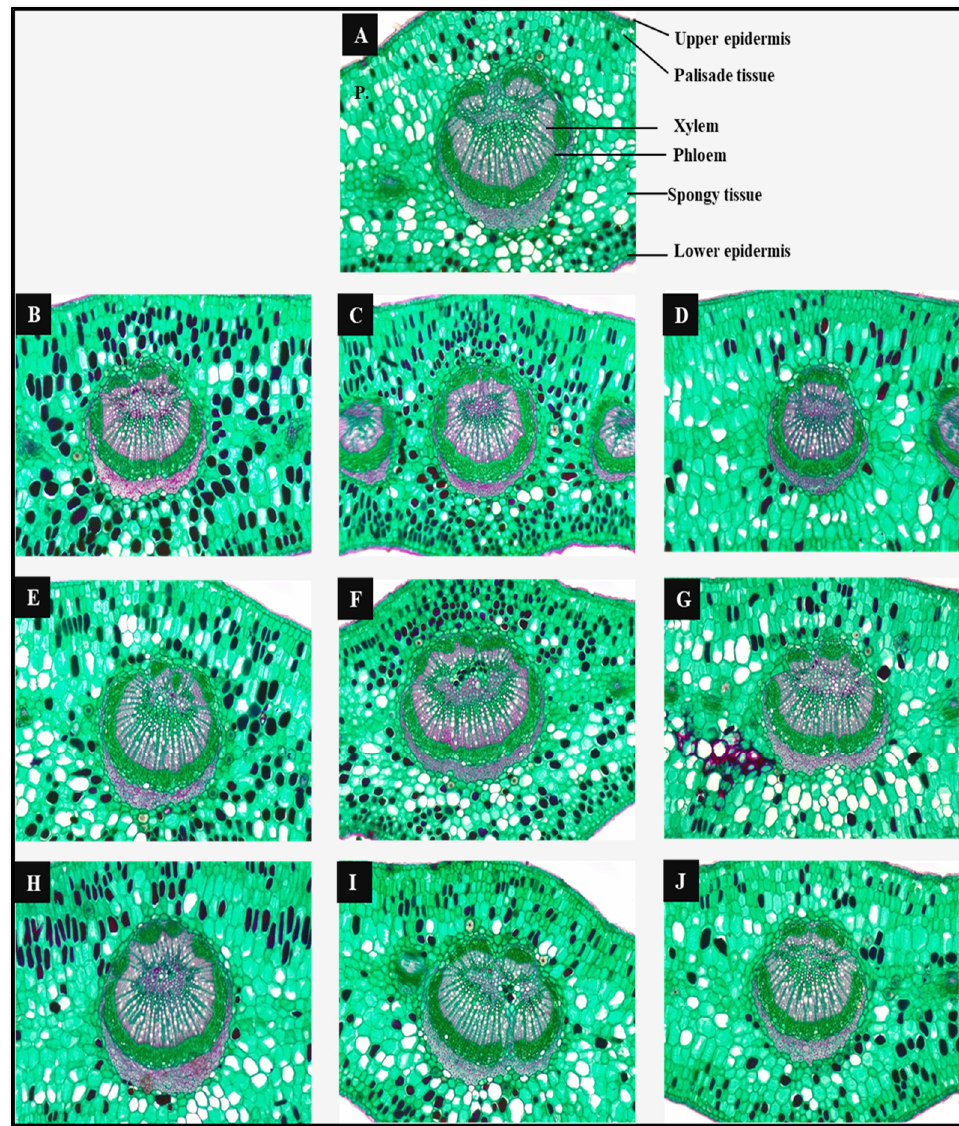
Figure 12. Microphotographs of transverse sections through the blade of leaves on the median portion of jojoba plants (135 days from the beginning of applying treatments) as affected by salinity and proline. ( A ), Control “tap water” without proline application; ( B ), 5000 ppm salinity without proline application; ( C ), 10,000 ppm salinity without proline application; ( D ), 15,000 ppm salinity without proline application; ( E ), 5000 ppm salinity with 300 ppm proline application; ( F ), 10,000 ppm salinity with 300 ppm proline application; ( G ), 15,000 ppm salinity with 300 ppm proline application; ( H ), 5000 ppm salinity with 450 ppm proline application; ( I ), 10,000 ppm salinity with 450 ppm proline application; ( J ), 15,000 ppm salinity with 450 ppm proline application. (Obj. × 10 and Oc. × 10.).